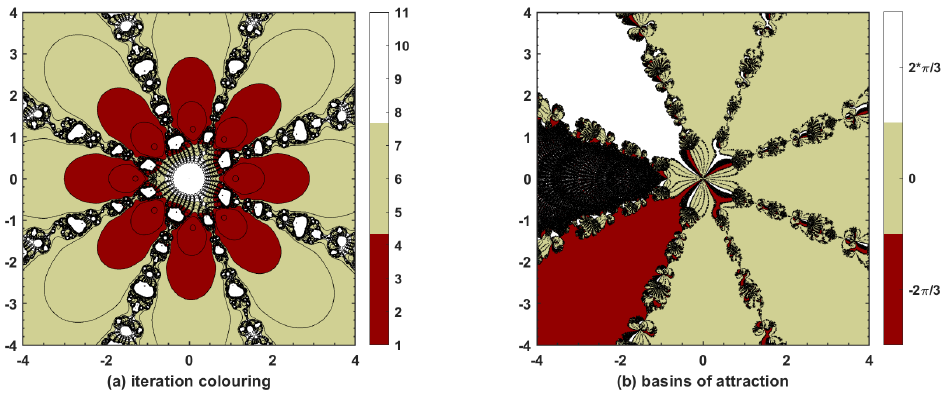
Figure 3. The polynomiographs by the proposed method PM 10 for P 1 ( z ) .